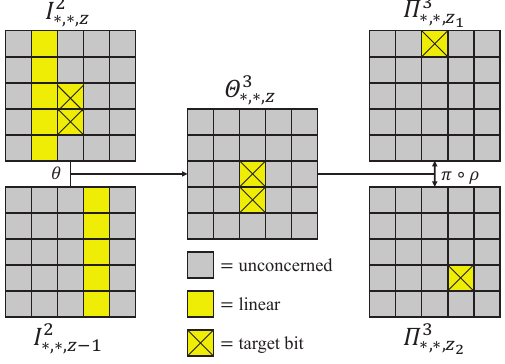
Figure 8: The idea of zero